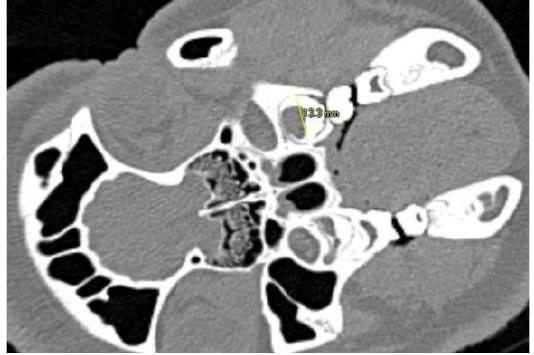
Figure 1. Visualization of the measuring procedure in CT-slices. Figure depicts measurement in buccal-oral axis. The outer contour of the tooth is determined as the interface between the hyperdense structure of the tooth and the hypodense structure of the desmodontal gap.